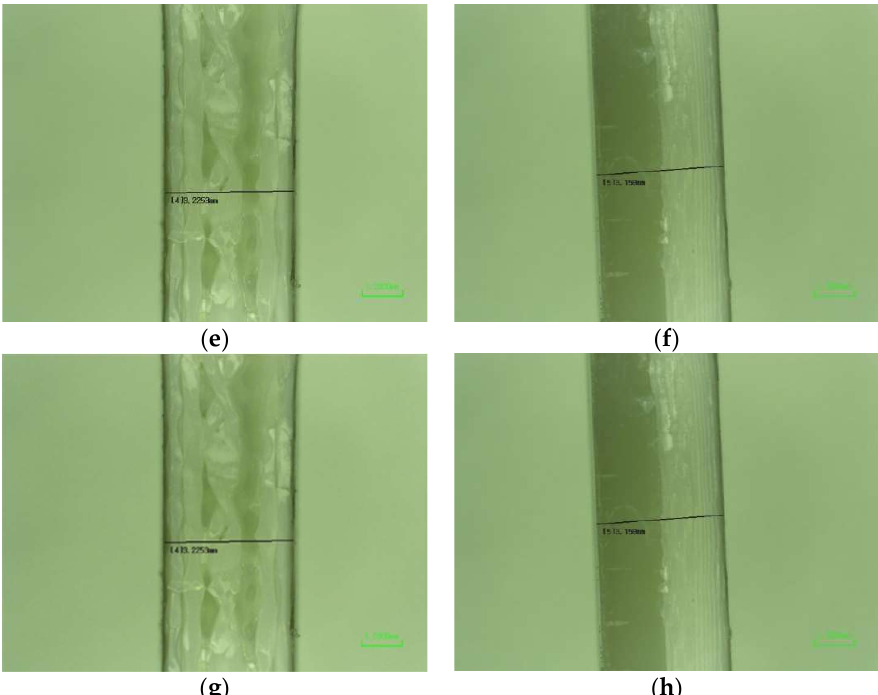
Figure 5. Images by Nikon Microscope for macrostructures and parameters of samples: ( a ) FDM 50, gauge width for 3.2083 mm; ( b ) FDM 50, thickness for 3.1438 mm; ( c ) IM, gauge width for 3.4501 mm; ( d ) IM, thickness for 3.1663 mm; ( e ) NJ 50, gauge width for 3.3092 mm; ( f ) NJ 50, thickness for 3.2167 mm; ( g ) FC 50, gauge width for 3.2253 mm; and ( h ) FC 50, thickness for 3.158 mm.